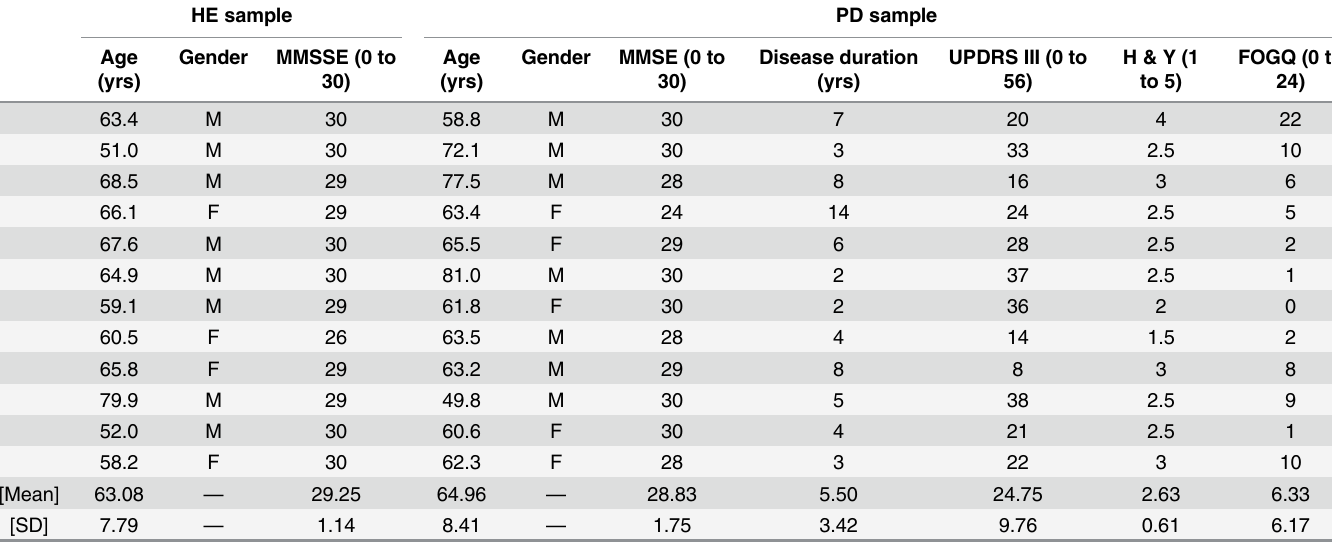
Table 2. Demographics of the PD and HE samples, and clinical characteristics PD